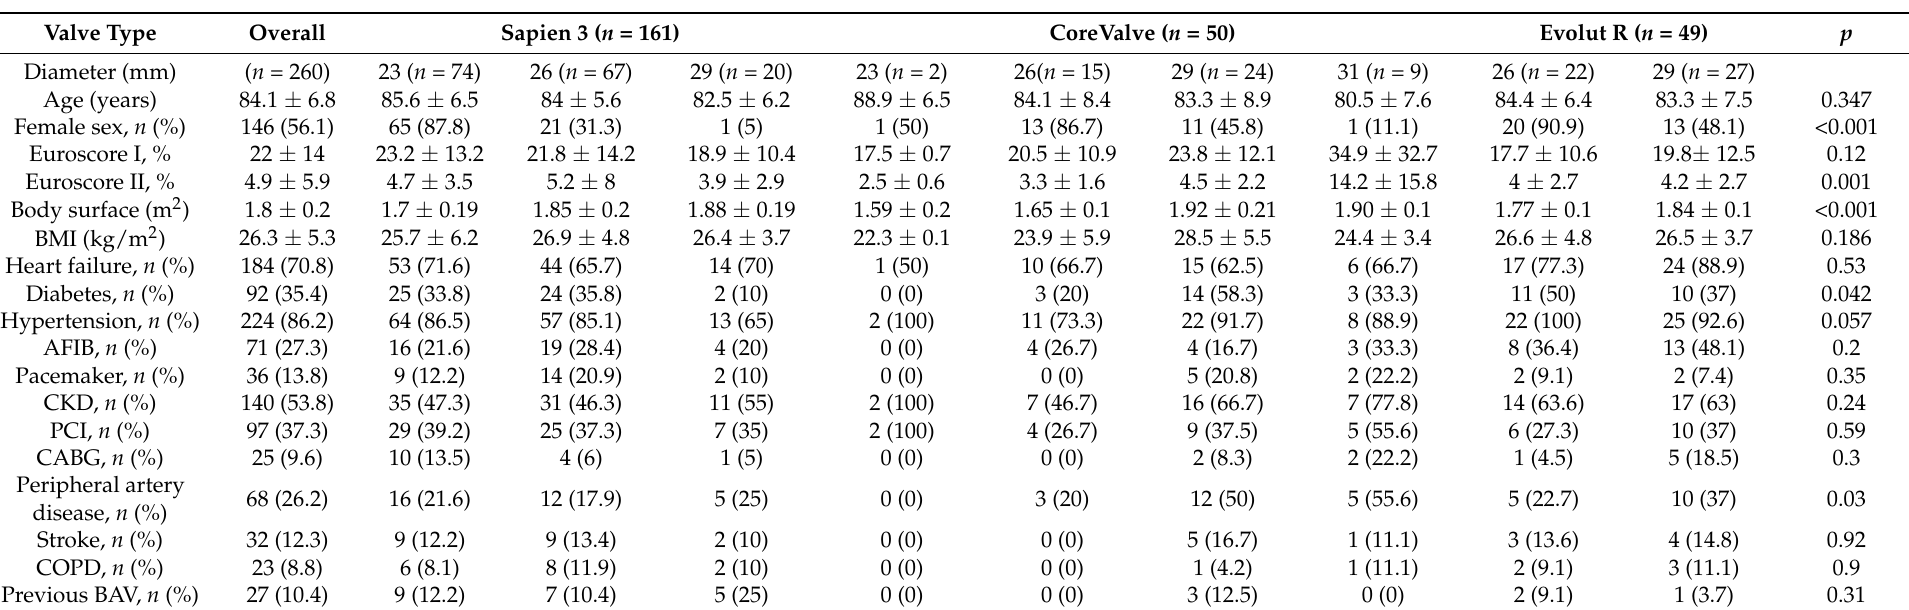
Table 1. Baseline characteristics of the study patients ( n =